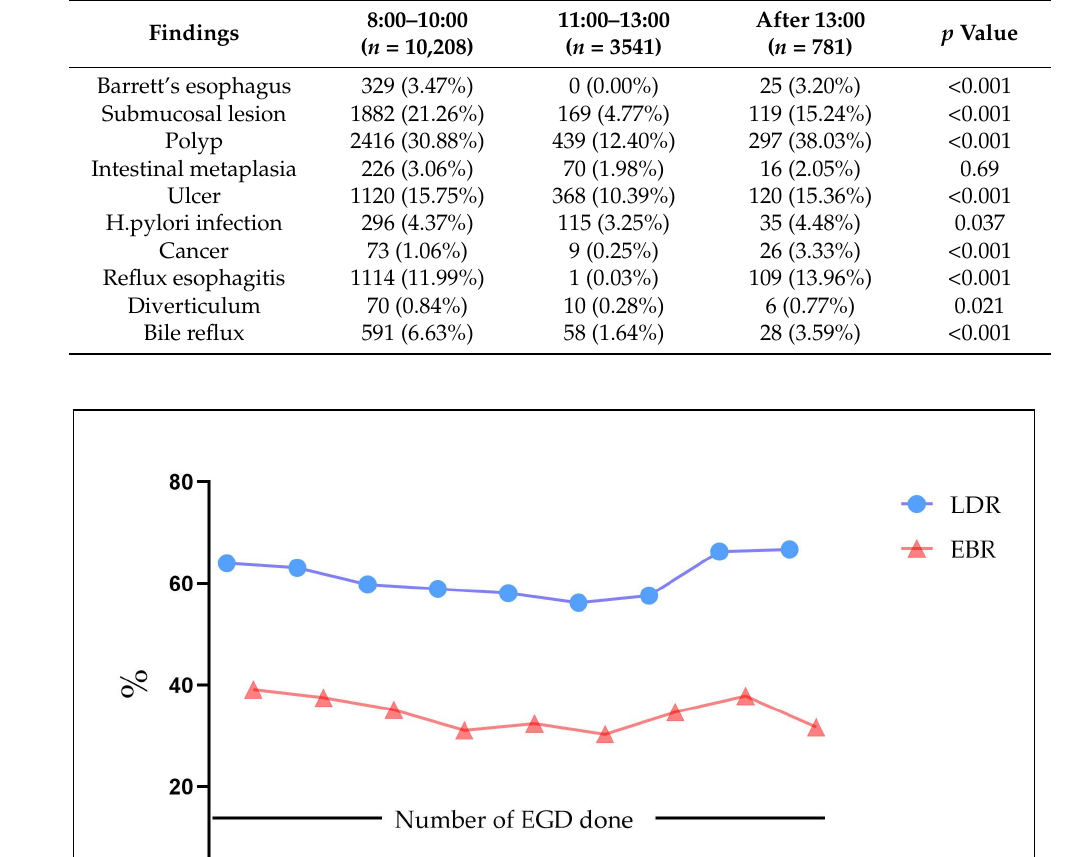
Table 2. Comparison of EGD findings among three time periods.